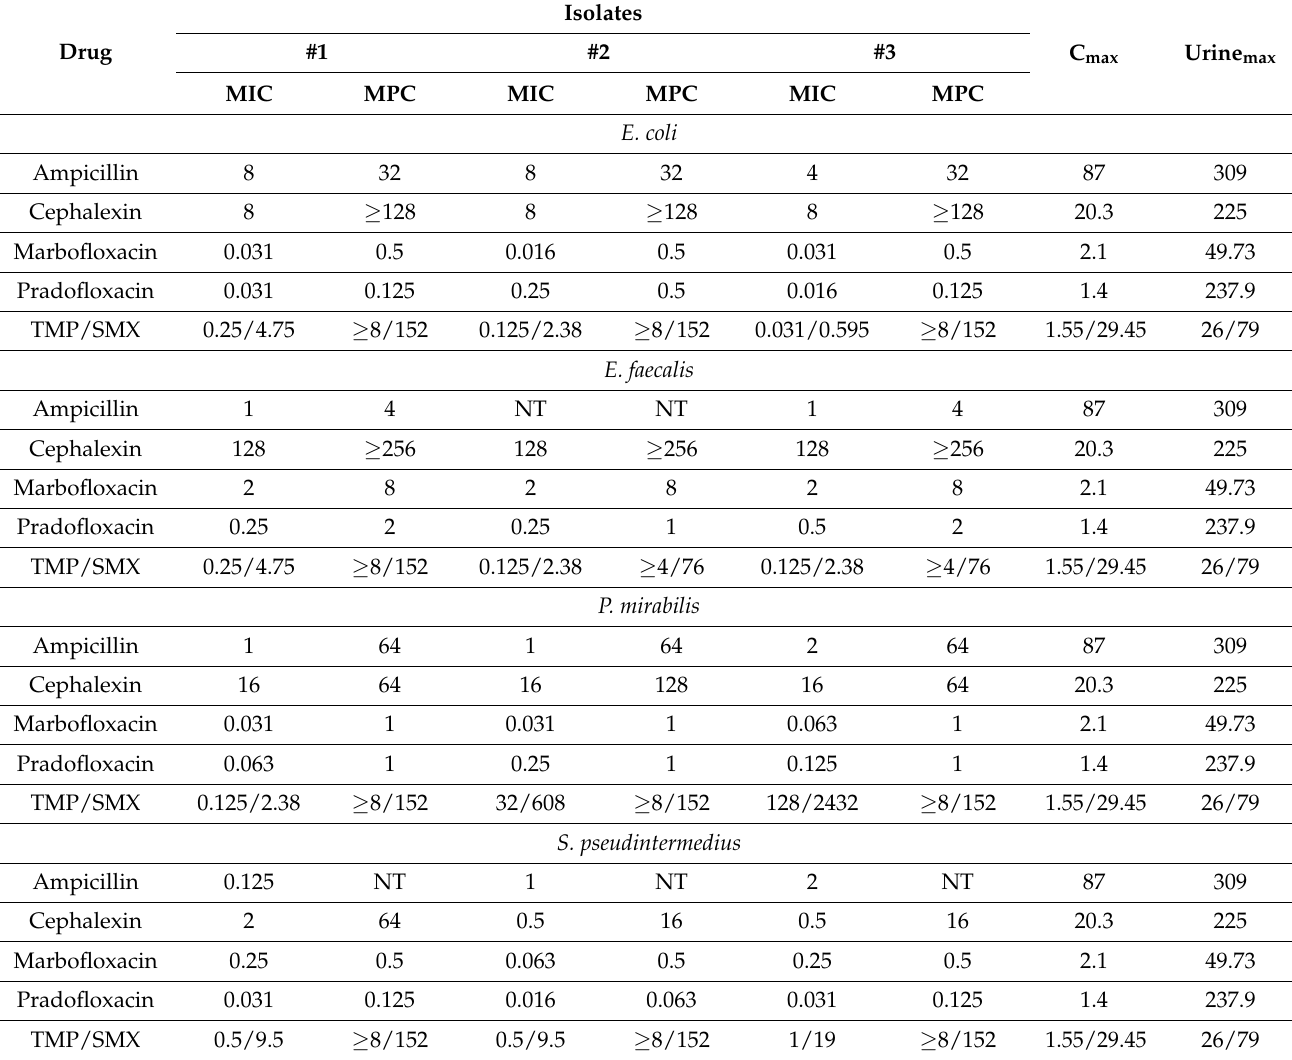
Table 1. Comparative MIC, MPC, and drug concentration